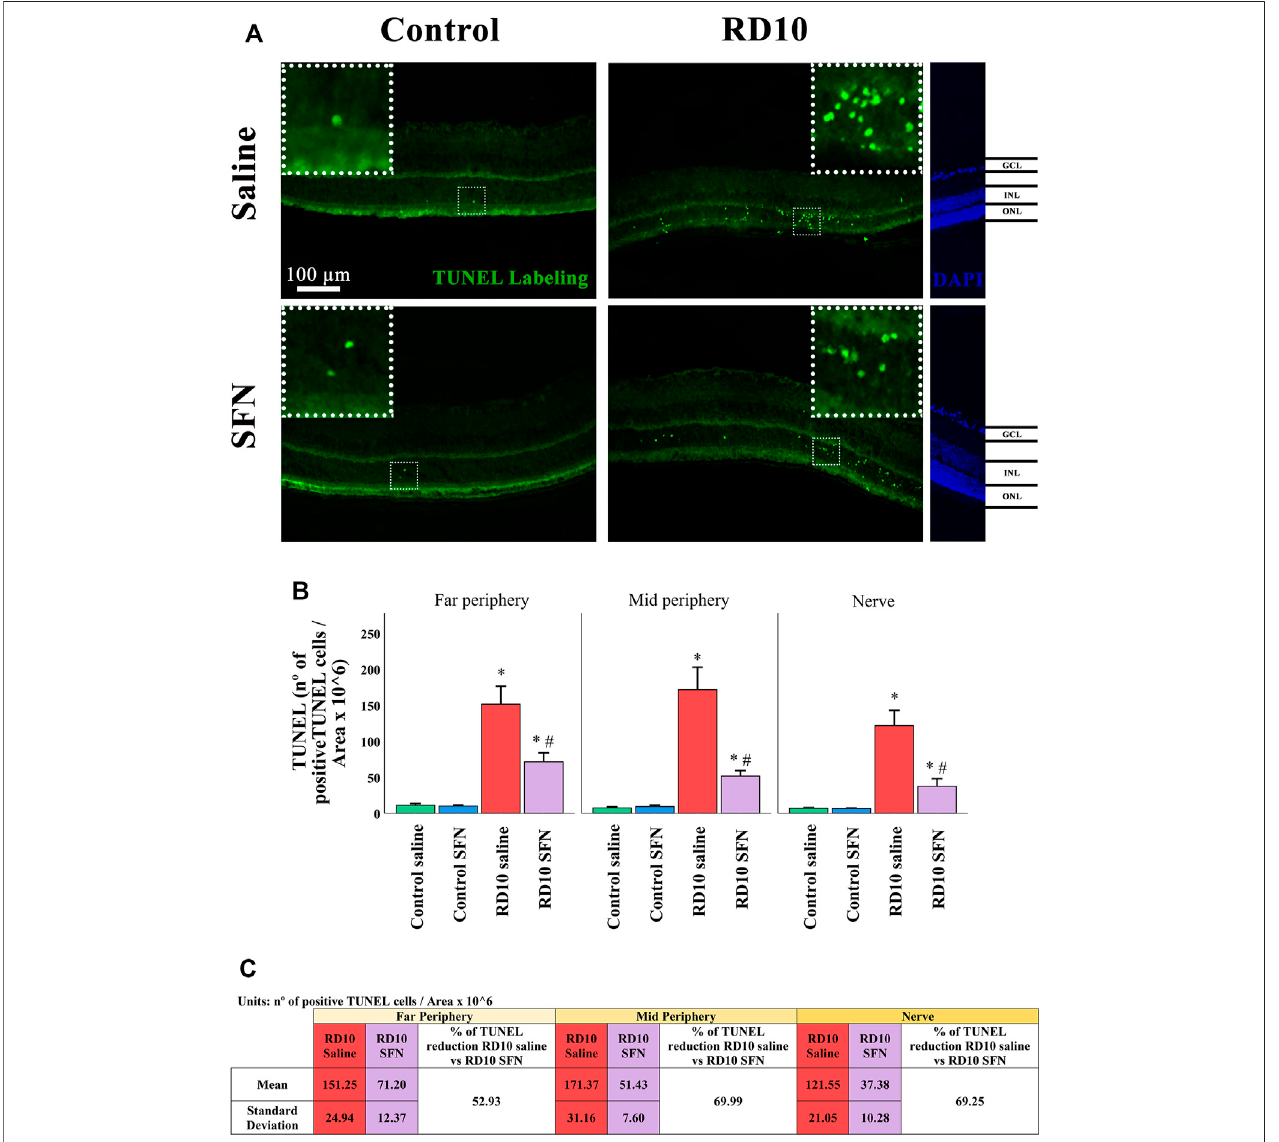
FIGURE 3 | Terminal deoxynucleotidyl transferase (TUNEL) cellular stain assessment. (A) Nerve region images of TUNEL immuno fl uorescence of the different groups in the experiment; the positive cells are pointed by white arrows. (B) The number of TUNEL-positive cells divided per area and multiplied per 10 6 . *Differences between Control Saline vs. RD10 Saline or Control SFN vs. RD10 SFN ( p -value < 0.05). #Differences between RD10 Saline vs. RD10 SFN ( p -value < 0.05). (C) Effect of SFN on RD10 mice TUNNEL cell count expressed by the mean, standard deviation, and percentage reduction of RD10 SFN with respect to the RD10 Saline.